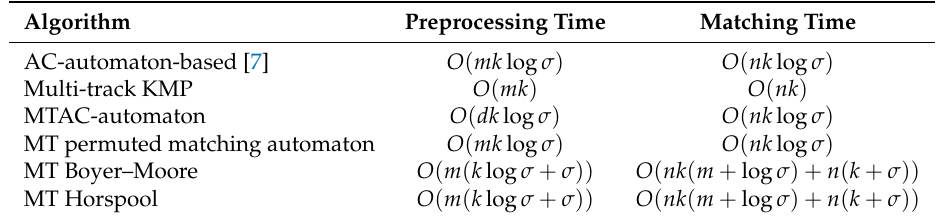
Table 1. Comparison of the algorithms for permuted pattern matching. Multi-track AC-automaton can find occurrences of multiple